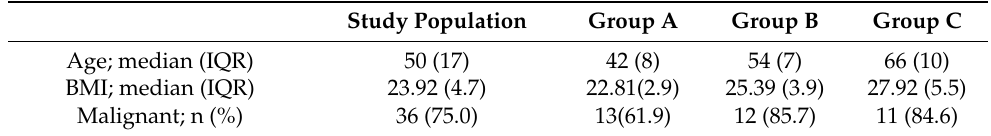
Table 1. Characteristics of the study population.